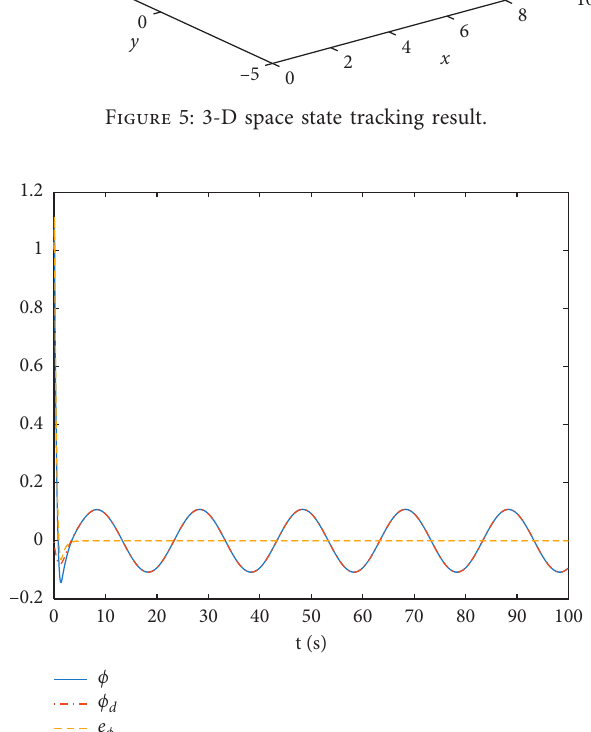
Figure 6: Trajectories of attitude ϕ , ideal position ϕ